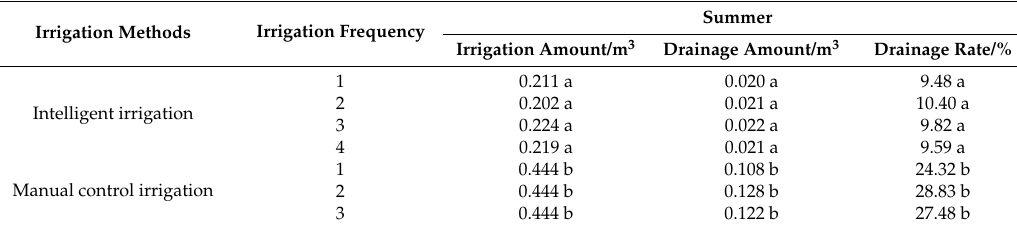
Table 5. Detail comparisons of drainage rate at different irrigation control treatments for 3